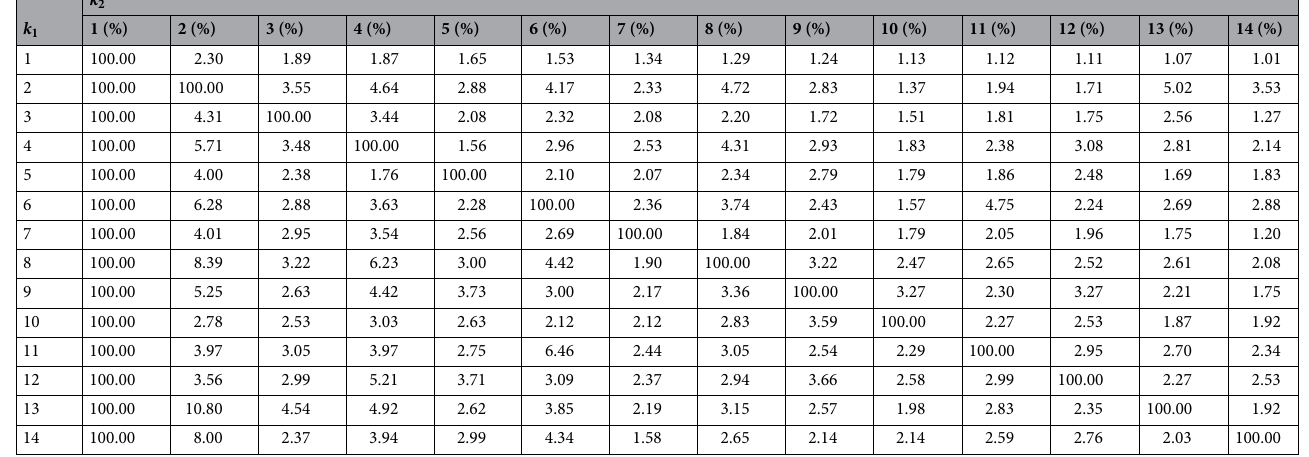
Table 5. Empirical probabilities of possessing at least latent features k 1 and k 2 given that k 1 is active. To compute the empirical probabilities, we looked at the number of patients that had latent feature k 1 active and counted how many of them also have latent feature k 2